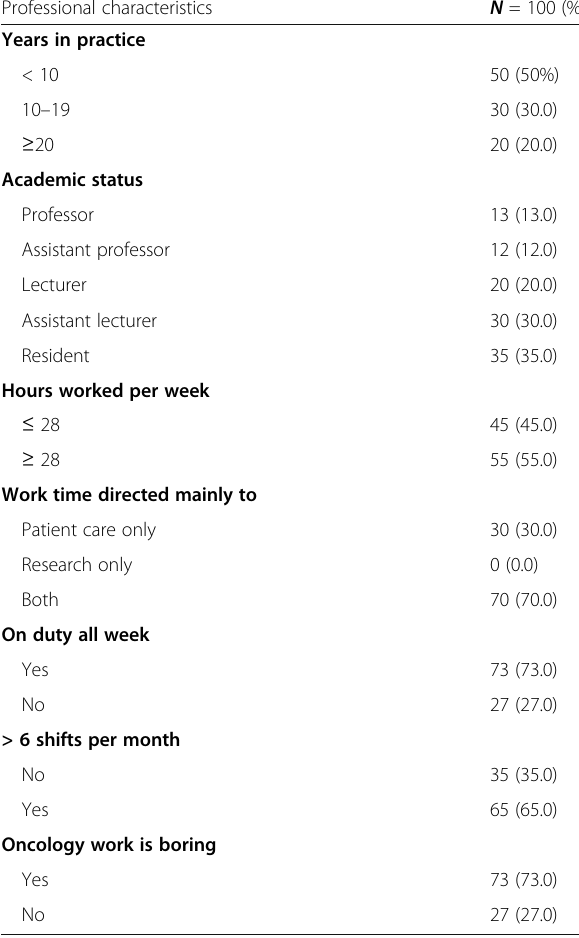
Table 3 Distribution of burnout and workplace stress scale grades among oncologists Overall ( n =